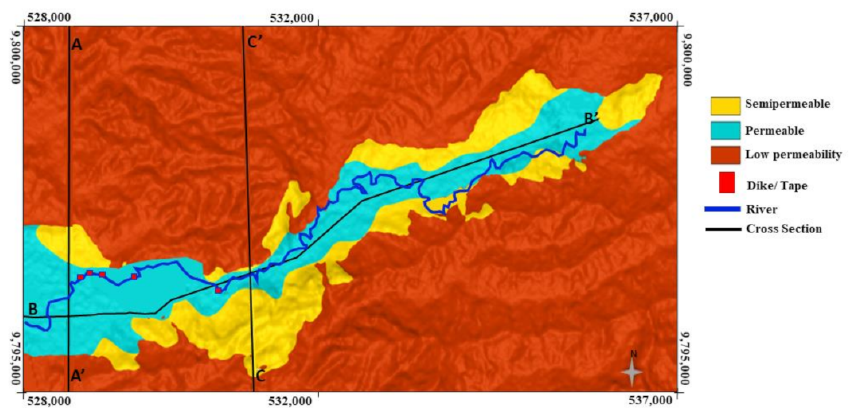
Figure 8. Plan view of the hydrogeological units